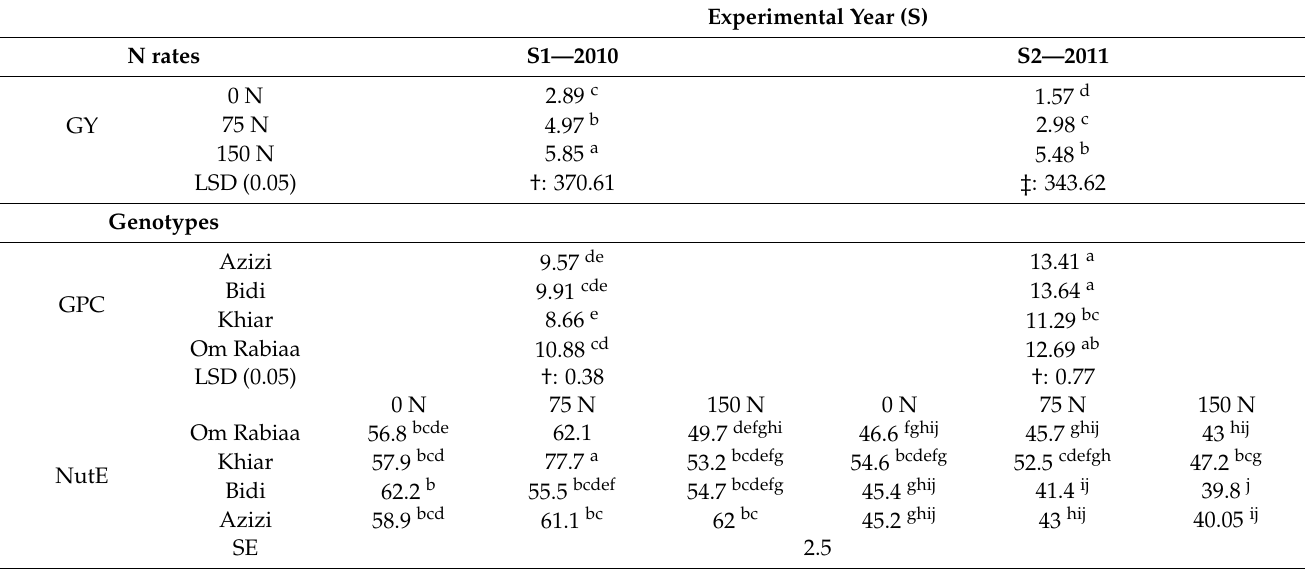
Table 4. Means of grain yield (GY; t ha − 1 ), grain protein content (GPC; %) and nitrogen utilization efficiency (NUtE; kg kg N − 1 ) of durum wheat genotype at different N rates in S1 (2010) and S2 (2011) (S × N, S × G and S × G × N,